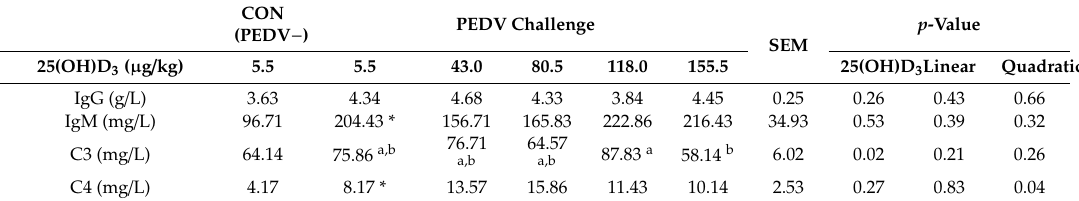
Table 4. Serum immunoglobulins and complement component levels of weaned piglets fed 25(OH)D 3 as indicated with PEDV challenge.